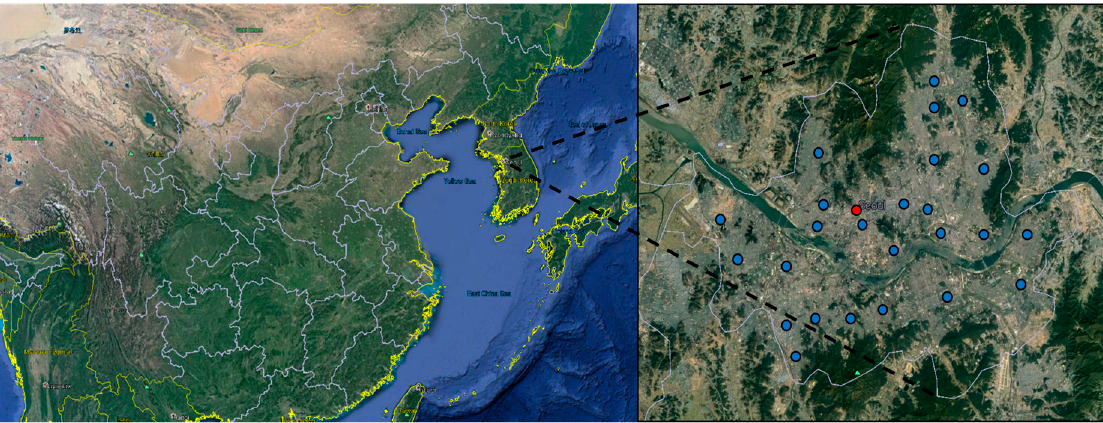
Figure 1. Monitoring sites of PM 10 (blue dots) and temperature (red dot) in Seoul, Korea (map obtained from Google Earth).